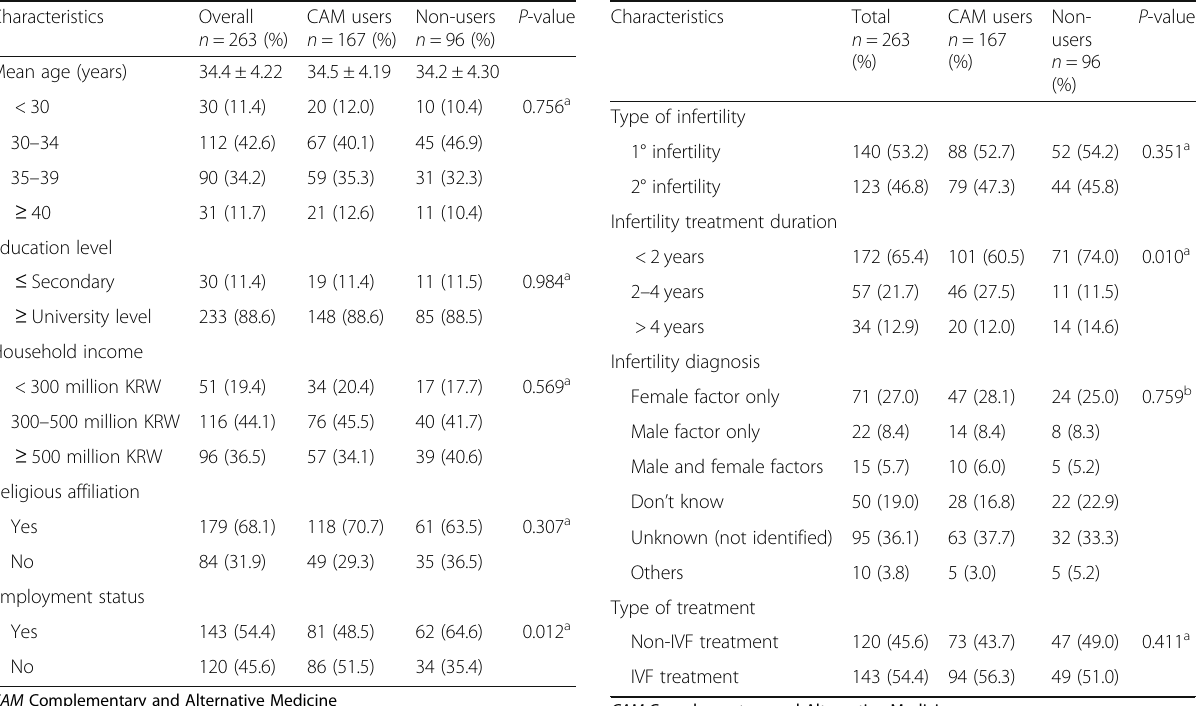
Table 2 Fertility-related characteristics of